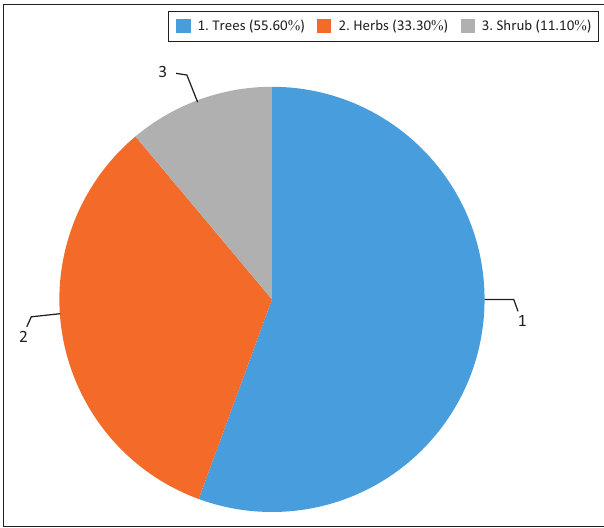
FIGURE 2: Growth habit of medicinal plants in the study